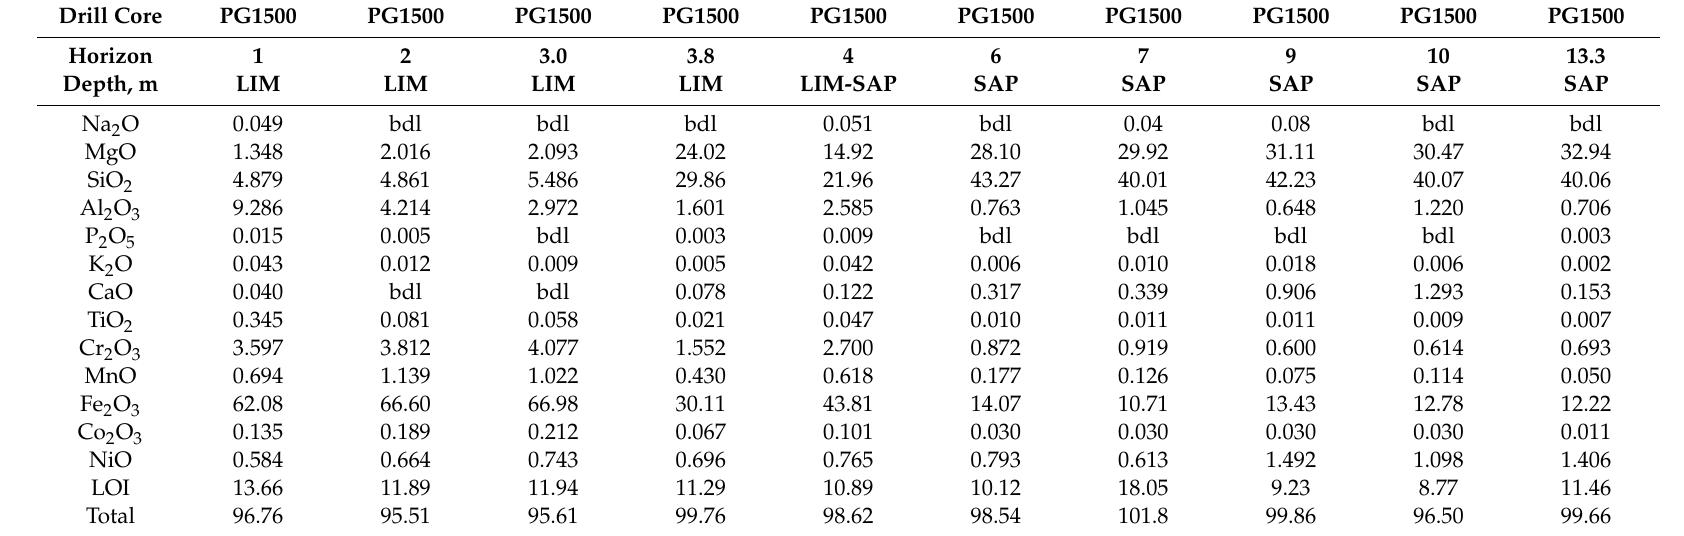
Table 8. Whole-rock chemical analyses (wt%) of the bedrock (BED), saprolite (SAP), and limonite (LIM) samples through PG1500